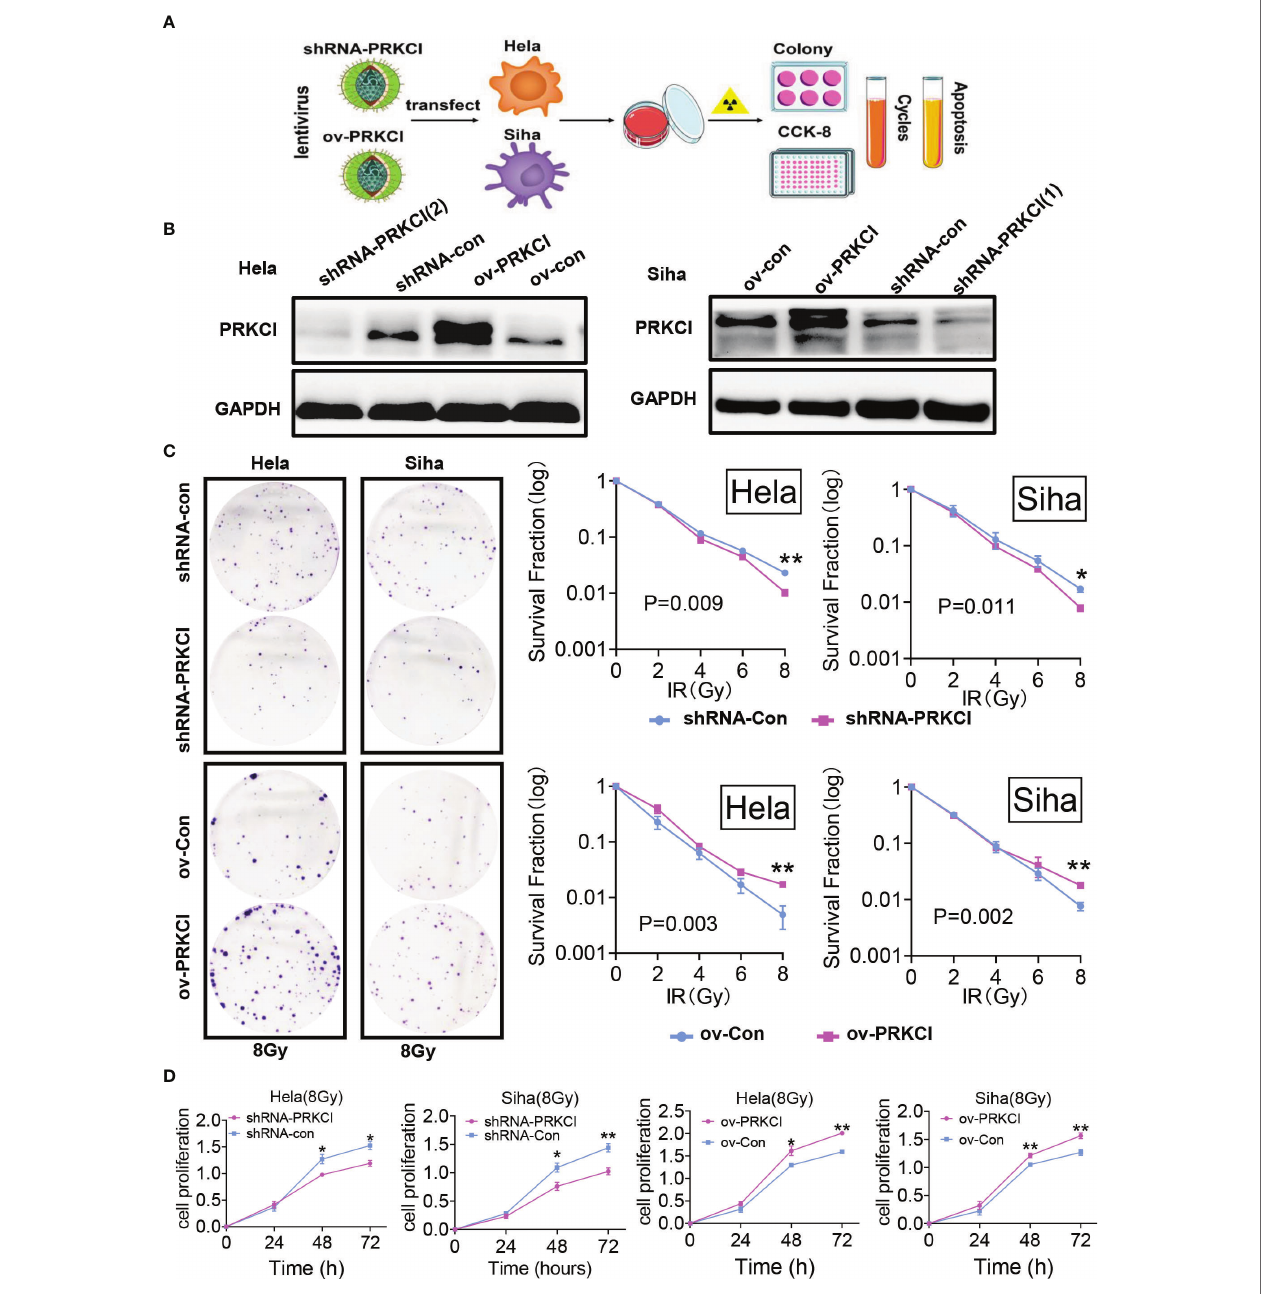
FIGURE 2 | In fl uence of PRKCI suppression and overexpression on radiosensitivity in CC cells in cell proliferation. (A) Work fl ow for PRKCI regulation and research of CC cells. (B) The shRNA-PRKCI and ov-PRKCI cells were veri fi ed for the downregulation and upregulation of HeLa and SiHa cells by Western blotting analysis. (C) In colony formation assays, the proliferation of the shRNA-PRKCI- and ov-PRKCI-transfected HeLa and SiHa cells was affected by radiotherapy in a dose- dependent manner. (D) The viability of the shRNA-PRKCI- and ov-PRKCI-transfected HeLa and SiHa cells after radiotherapy at 8 Gy were determined by CCK-8 assays. Data are shown as the mean ± SD (C, D) . *p < 0.05; **p < 0.01 by multiple t-tests (C, D) . CC, cervical cancer; CCK-8, Cell Counting